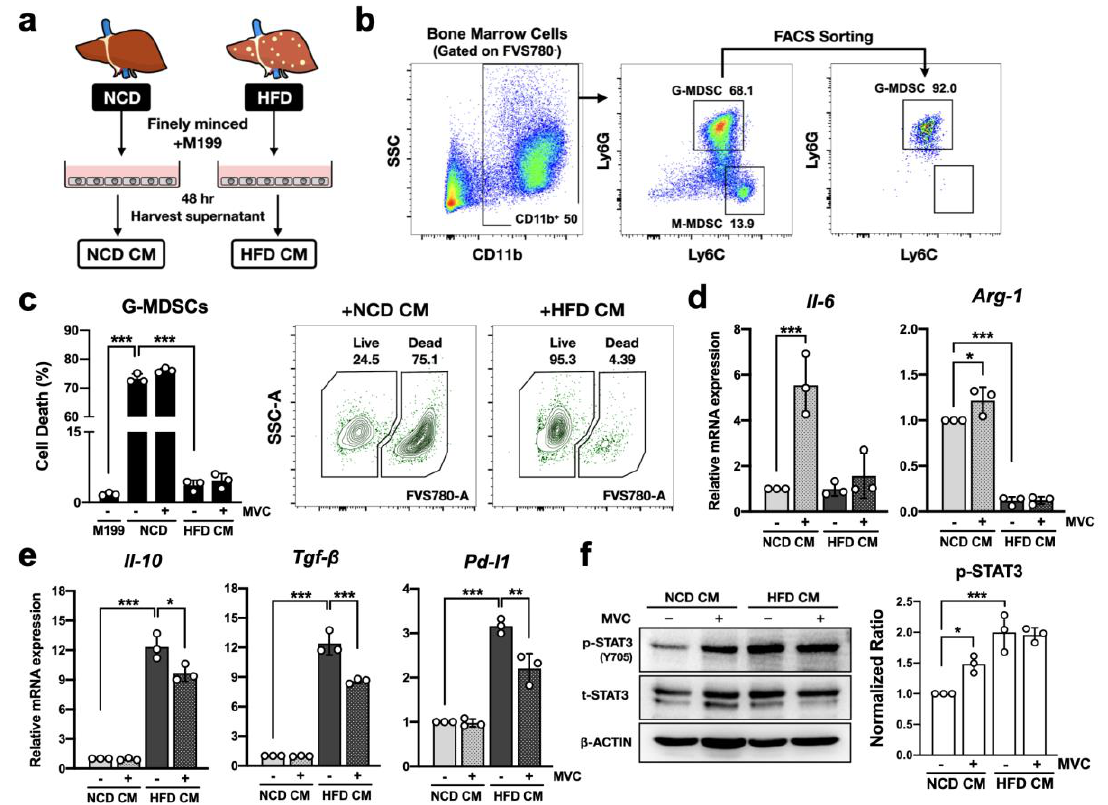
Figure 4. CCR5 signaling modulates the anti-inflammatory profile of g-MDSC in the hepatic microenvironment. ( a ) A schematic diagram of preparing liver-conditioned M199 culture medium (CM). ( b ) Primary g-MDSCs were isolated from WT bone marrow cells by FACS sorting. ( c ) Isolated g-MDSCs were pretreated with 5 μM Maraviroc (MVC) (+) or vehicle control (− ) for 1 h and then stimulated with indicated liver-CM for 18 h. Cells were also treated with vehicle control and M199 medium as a negative control. Dead cells were quantitated by flow cytometry after fixable viability staining with FVS780. Additionally, g-MDSCs’ transcript levels of genes related to STAT3 activation ( d ) and anti-inflammation ( e ) were determined by real-time PCR. Expression was normalized to the 36b4 reference gene and further normalized to the average value of the first group (n = 3). ( f ) Primary WT g- MDSCs were pretreated with 5 μM MVC (+) or vehicle control ( − ) for 1 h and then stimulated with indicated liver-CM for 10 min. The levels of phosphorylated and total STAT3 were determined by immunoblotting. The signal of phosphorylated STAT3 was normalized to total STAT3 and set the first group as 1 (n = 3). *, p < 0.05; **, p < 0.005; ***, p < 0.001.